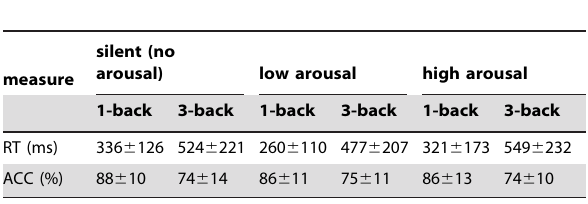
Table 2. Behavioral results of the 22 subjects (data are presented as mean 6